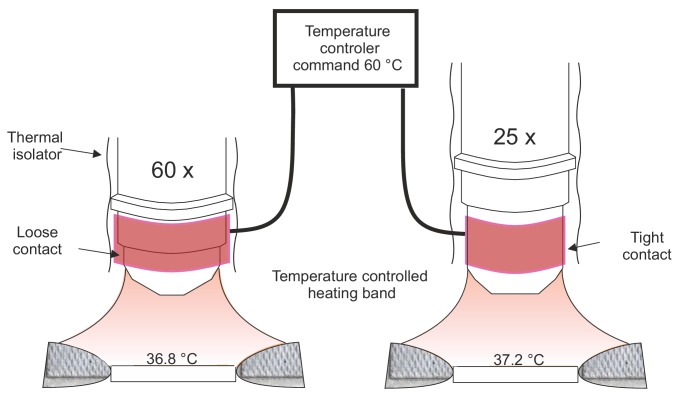
Objective heating system.Left, the objective heater consists in a heating band with a temperature feedback connected to a temperature controller. In all experiments, the temperature command was set to the maximum value (60°C). In addition, a polyimide film (thermal isolator) was enwrapped around our 60X objective (NA = 1.1). Due to its shape, the objective was not in tight contact with the entire band width and the glass temperature could not reach ~37°C. Right, this was not the case with the large 25X objective (NA = 1.05), which straight shape ensured a tighter contact with the band and a higher glass temperature.